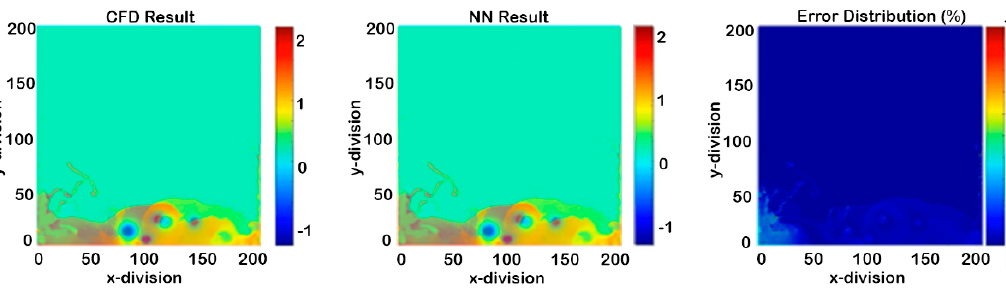
Figure 22. Cascading results of Model Ⅱ for phase fraction (seven time-steps after deployment).